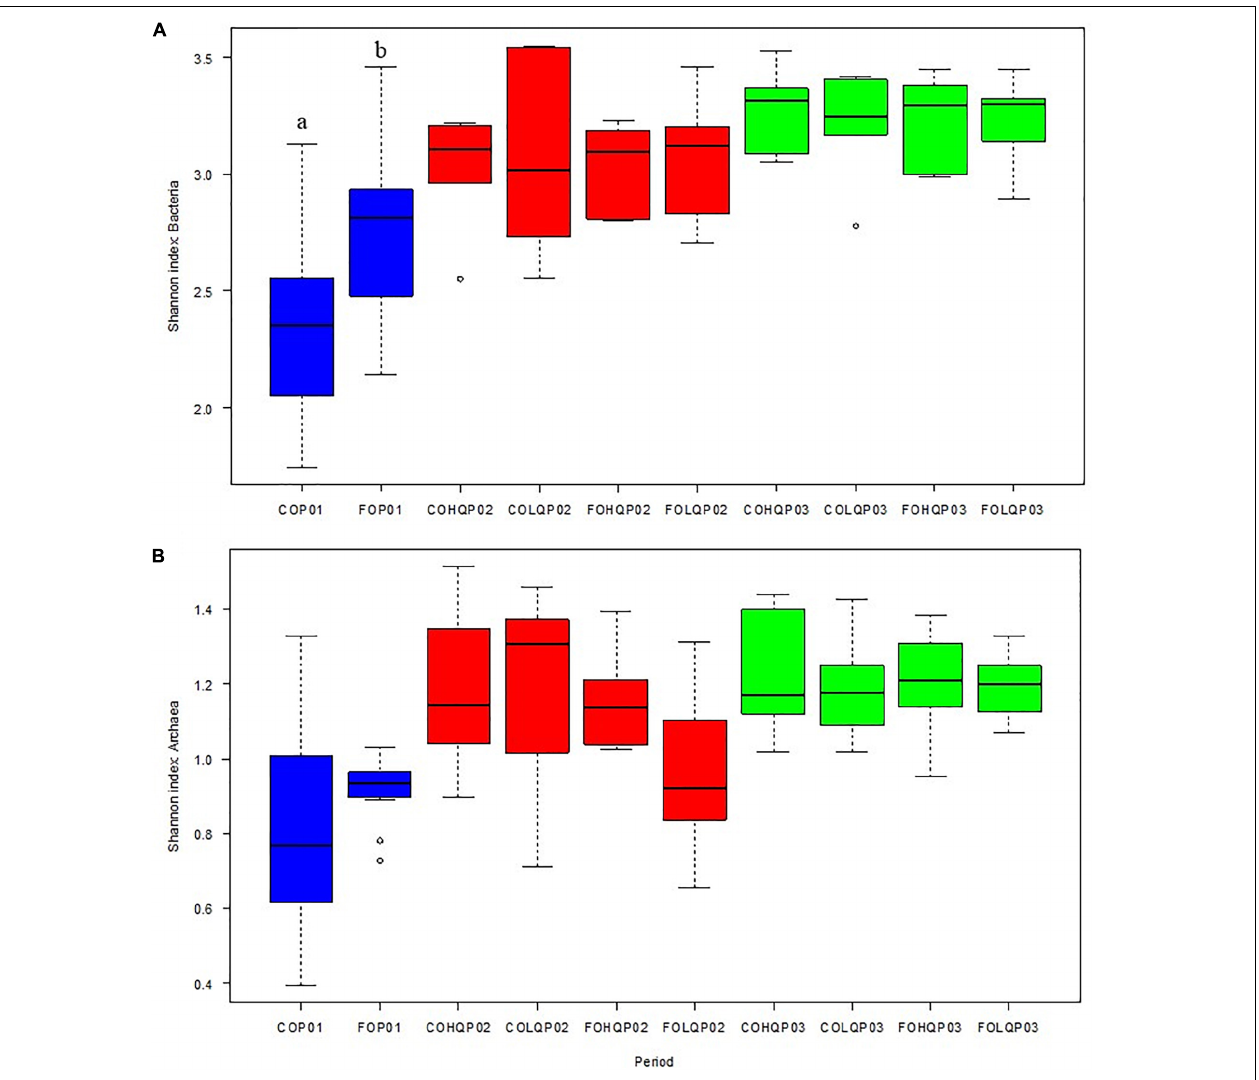
FIGURE 1 | Effects of dietary treatments in the Shannon diversity indices of the microbial communities in the rumen of calves during the three measurement phases. The alpha diversity of dietary treatment concentrate (CO) vs. pasture (FO) during phase 1 (P01; blue) and the combination of dietary treatments from P01 and high-quality (HQ) vs. low-quality (LQ) pastures from phase 2 (P02), resulting in FOHQ, FOLQ, COHQ, and COLQ, evaluated during P02 (red) and phase 3 (P03; green) are shown for (A) bacteria Shannon index and (B) archaea Shannon index. Boxplots represent the 25th and 75th percentiles, the whiskers extend to the most extreme data points, lines within boxes are the medians, and dots represent